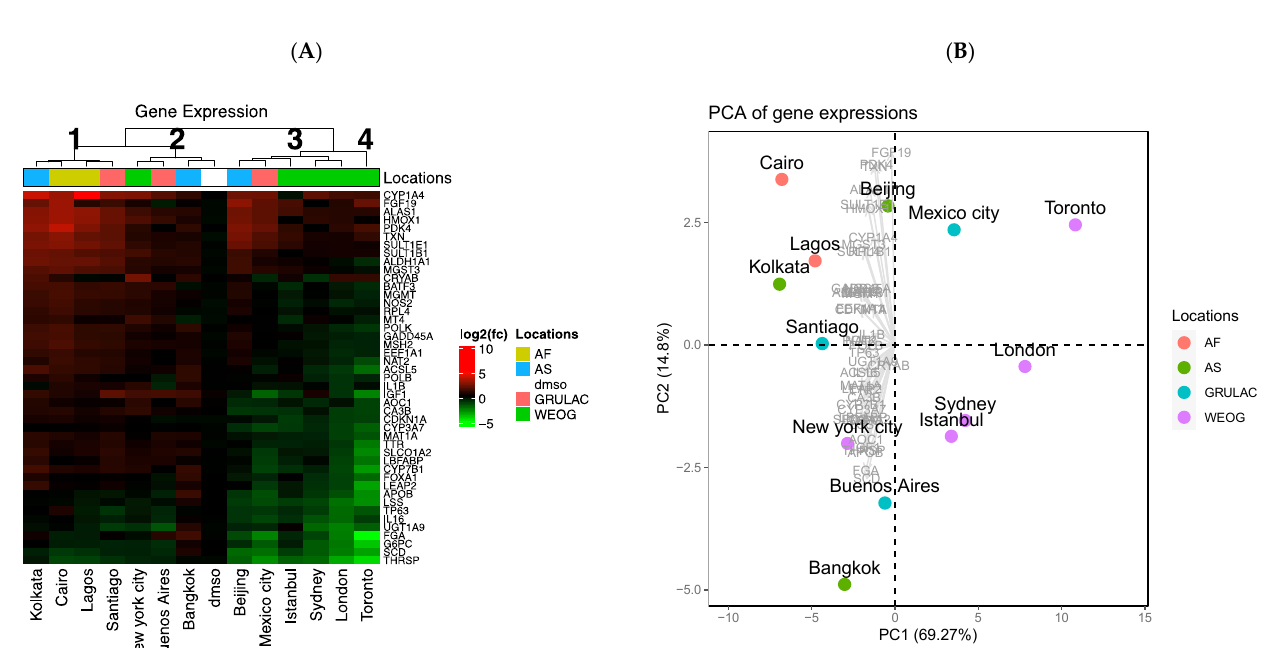
Figure 4. Gene expression analysis by chicken ToxChip PCR array of 13 megacities in five global regions (location details in Figure 1) depicted by ( A ) hierarchical clustering (red and green hues indicate upregulation and downregulation); and ( B ) principal component analysis. Gene expression loadings for the most responsive transcripts are depicted by arrows on the graph .